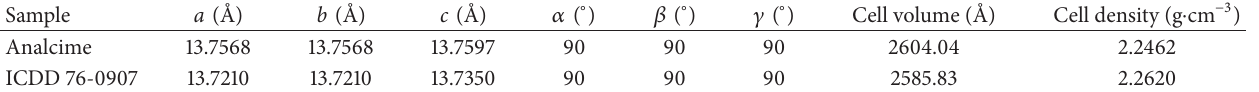
Figure 5: XRD patterns of the solid samples and the results of potassium extraction ratio at different temperatures. Table 3: The calculated lattice parameters of prepared analcime obtained at optimal conditions.